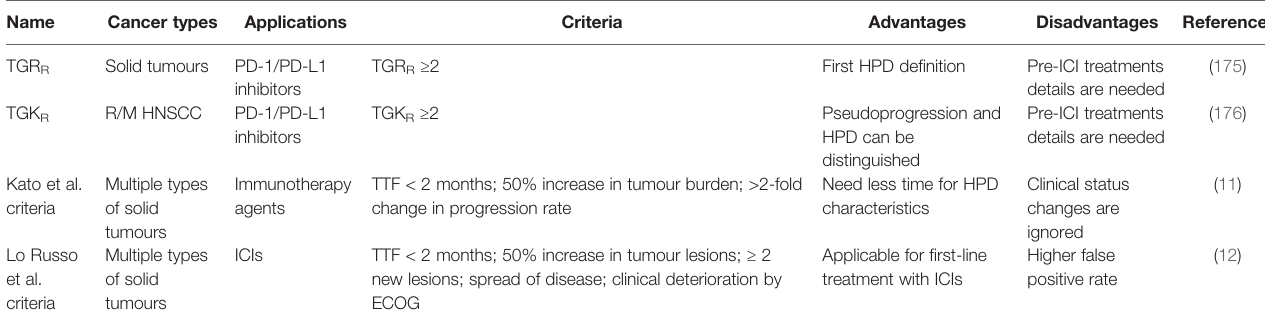
TABLE 2 | Different criteria for HPD from clinical perspective [adapted from Table from the paper of Hongjing et al.